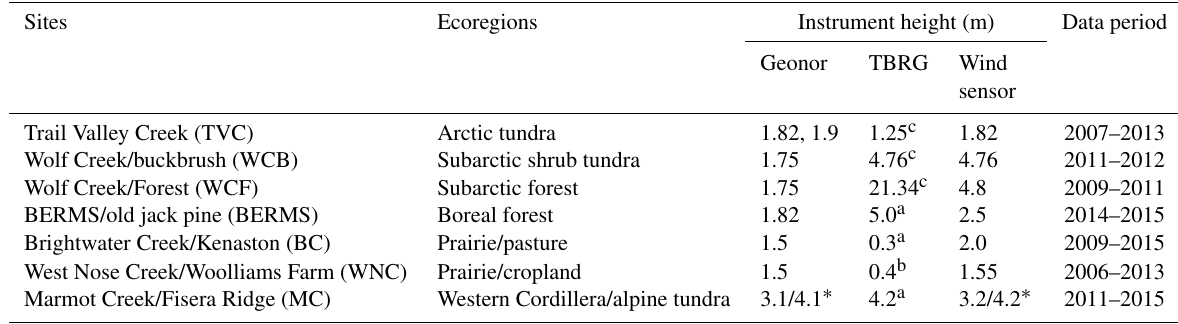
Table 1. Summary of site and instruments info, including heights of the precipitation gauges and wind sensors.